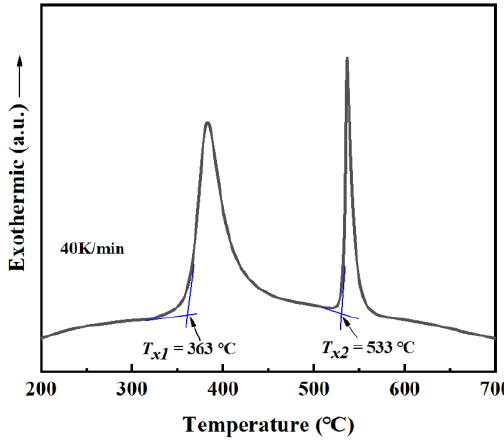
Figure 2. The DSC and TG curve of FeCoSiBPC amorphous alloy.